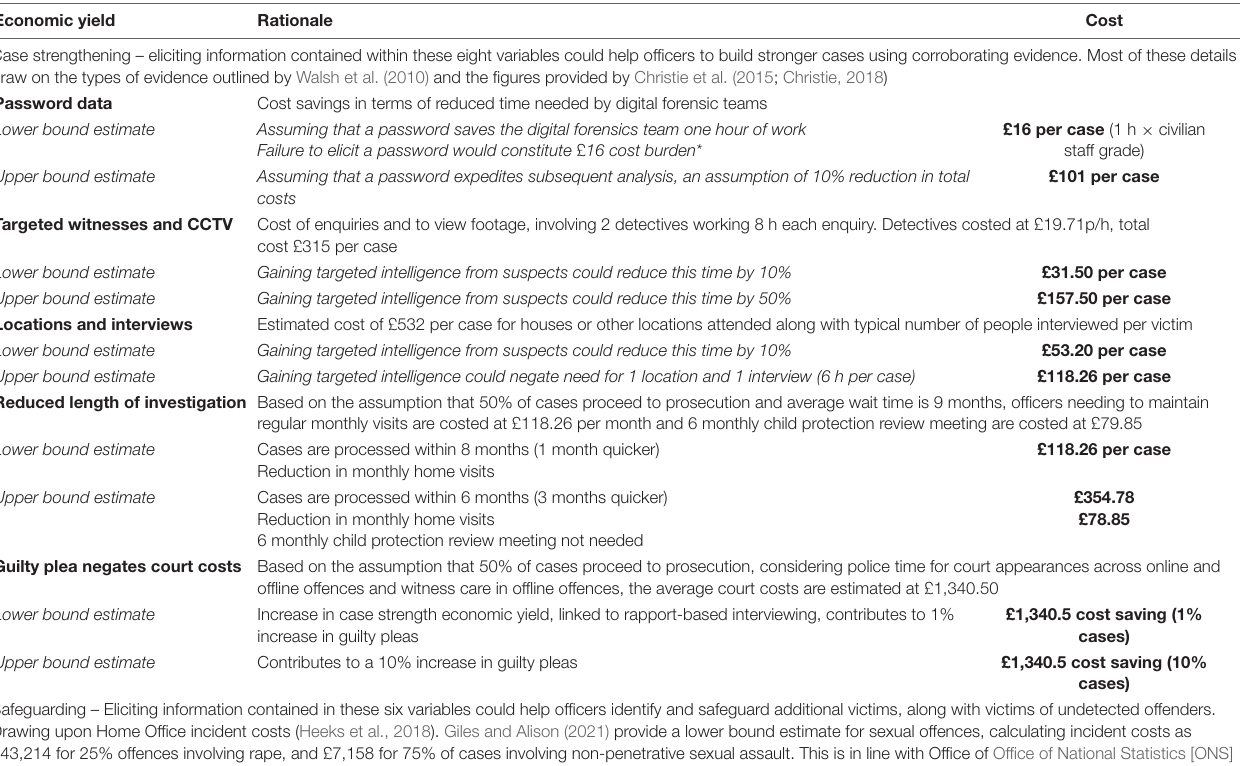
TABLE 1 | Economic framework applied in the present